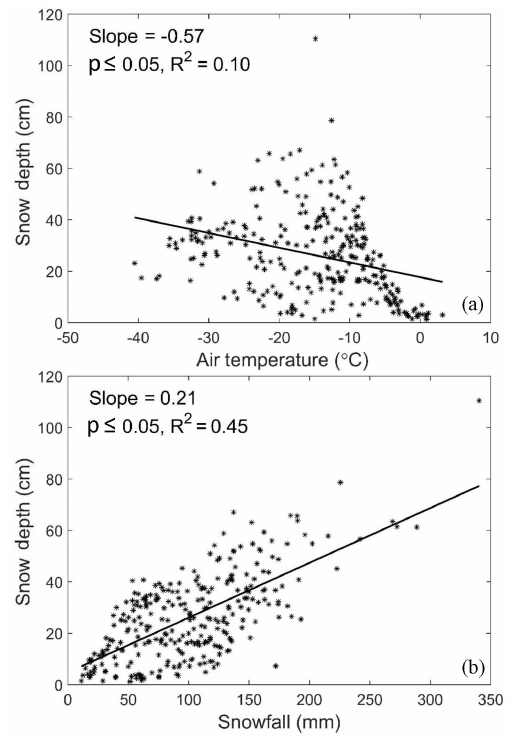
Figure 9. Relationship between long-term mean annual snow depth and air temperature (a) and between long-term mean annual snow depth and snowfall (b) from 386 stations from November through March during 1971–2000 over the USSR. The thick line is a linear regression